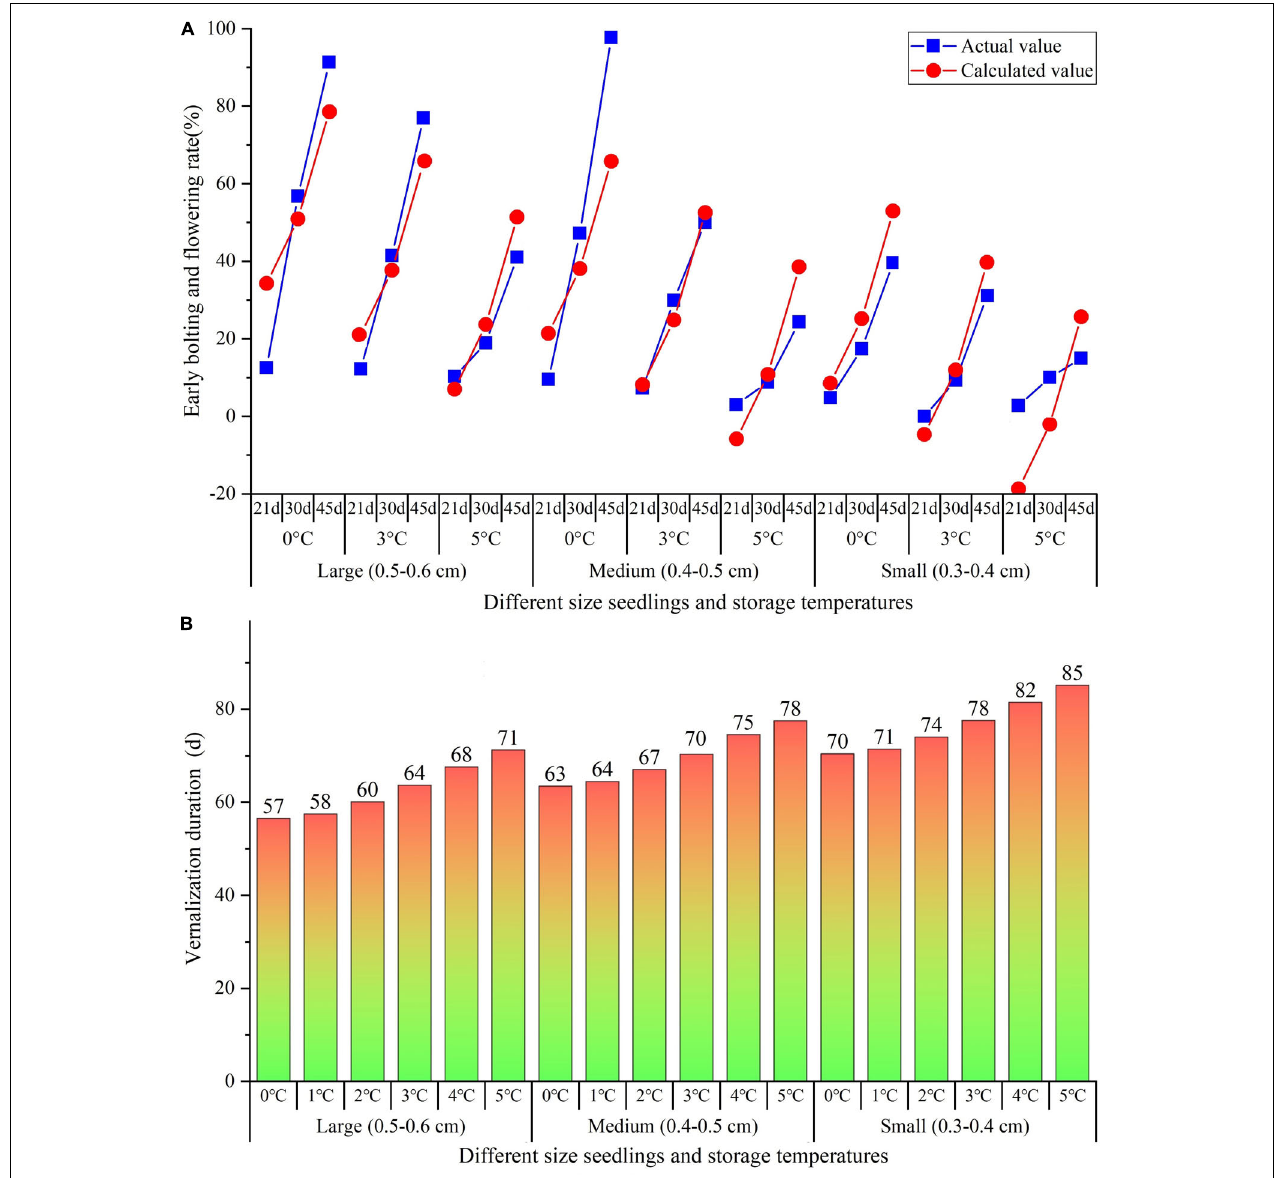
FIGURE 4 | Linearization regression analysis on the relationship of EBF rate with VT, VD, and SC (A) , as well as speculated the precise VT and VD of different size seedlings (B) . VT, vernalization temperature; VD, vernalization duration; and SC, seedlings